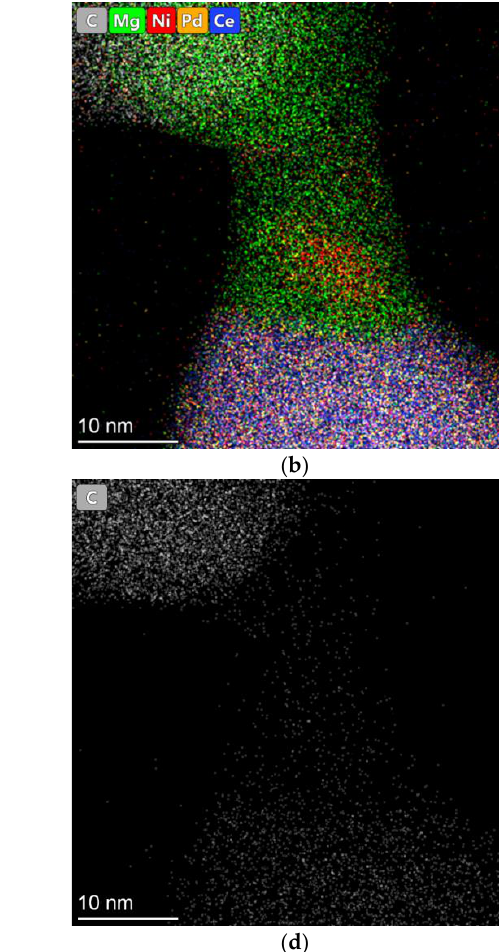
Figure 10. EDX mapping of the ( a , b ) spent Ni-Pd/CeMg-A-S-V catalysts, ( c , d ) C elemental map.